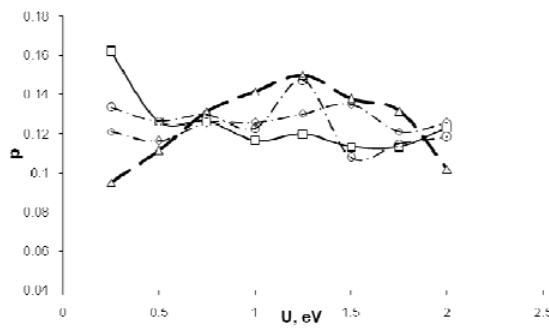
Fig. 3. Distribution functions U(  ) for sections 4, 5, 6, 7 ( □ -4, ∆ -5, ○ -6,- ◊ -7)